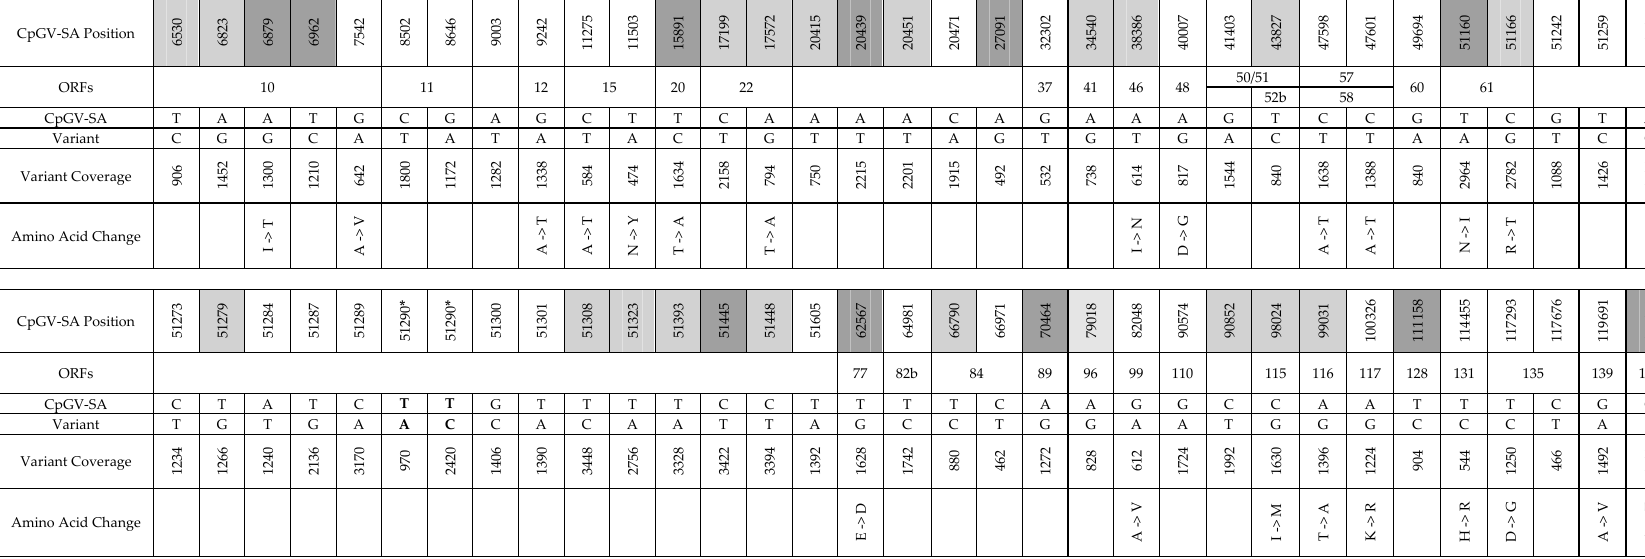
Table 2. Alignment of 66 genotypic SNVs identified within the CpGV-SA complete genome sequence. Variants which overlap with SNPs identified between the CpGV isolates are in light grey while those which overlap with SNPs unique to CpGV-SA (Table 1) are in dark grey. The corresponding ORF numbers are provided above the alignment for SNVs occurring within coding regions while any resulting amino acid substitutions are shown below. Nucleotides: A = Adenine, C = Cytosine, G = Guanine, T = Thymine and amino acids: A = Alanine, R = Arginine, N = Asparagine, D = Aspartic acid, E = Glutamic acid, G = Glycine, H = Histidine, I = Isoleucine, K = Lysine, M = Methionine, T = Threonine, Y = Tyrosine, and V =